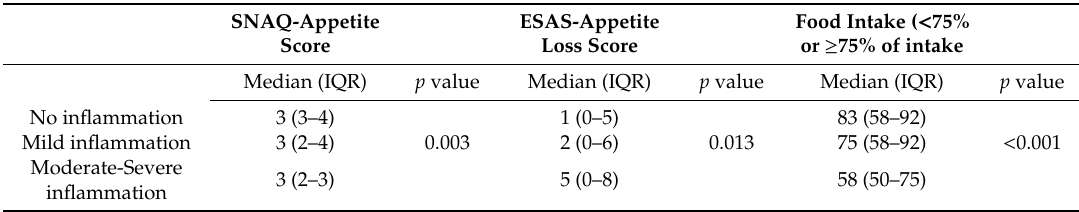
Table 2. Association between CRP levels and appetite scores and food intake in total population ( n = 200).